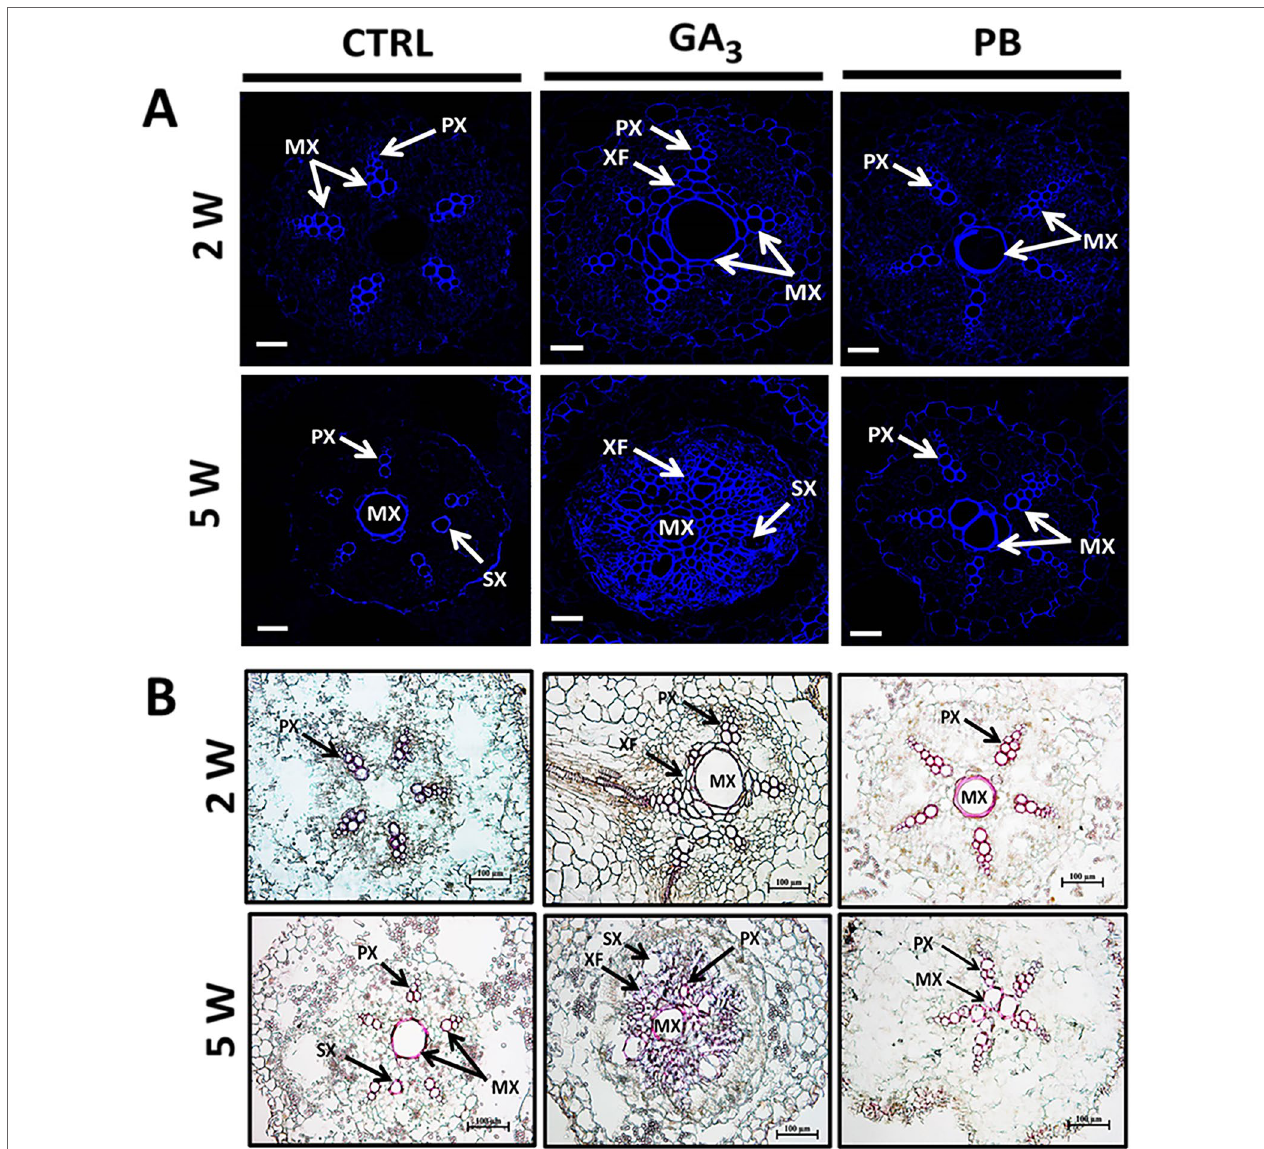
FiGURe 6 | Effect of GA 3 application on sweetpotato “ Georgia Jet ” root lignin accumulation as viewed by auto-fluorescence imaging (a) and phloroglucinol-HCl staining (B) . Representative cross-sections of adventitious roots sampled at two and five weeks (2W and 5W, respectively) after planting. Use of autofluorescence imaging (a nonspecific tool indicative of lignin and various phenolics) specifying secondary-wall material deposition in xylem showing blue fluorescence under UV excitation at 365 nm, points to lignin accumulation in xylem elements including proto-, meta-, and secondary xylem, and xylem fibers (a) . Phloroglucinol- HCl staining (being more specific and indicative of 4-O-linked hydroxycinnamyl aldehyde structures in lignins) stained lignified cells wall, where lignin deposition appears as pink-red color in proto-, meta-, and secondary xylem, and xylem fibers (B) . Presented sections represent six to eight roots sampled from individual plants. CTRL, Control (treated with water); GA 3 , application of 50 ppm gibberellic acid 3 for two weeks; PB, application of 5 ppm paclobutrazol for two weeks. PX, protoxylem; MX, metaxylem; SX, secondary xylem; XF, xylem fibers. Scale bar = 50 µm (a) and 100 µm (B) .